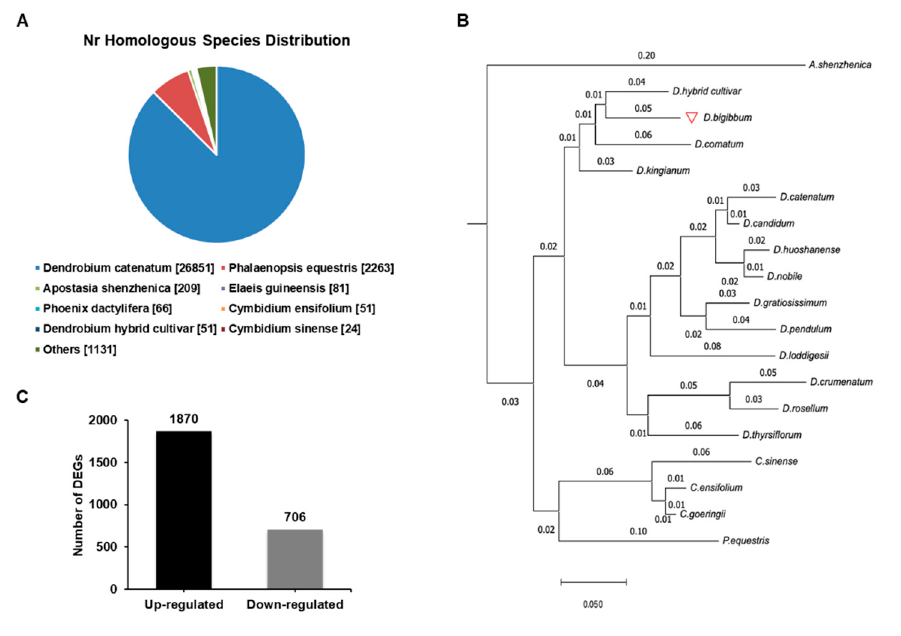
Figure 3. Species distribution of the BLAST search results in the nr database. ( A ) A cut off E-value of 10 -5 was used. Different species are indicated by different colors. ( B ) A reference phylogenetic tree derived from rDNA ITS 2 sequences of 14 species of Dendrobium , 3 species of Cymbidium , Apostasia shenzhenica , and Phalaenopsis equestris . ( C ) The number of up- and downregulated differentially expressed genes (DEGs) in the wild type versus RB016-S7 mutant comparison.